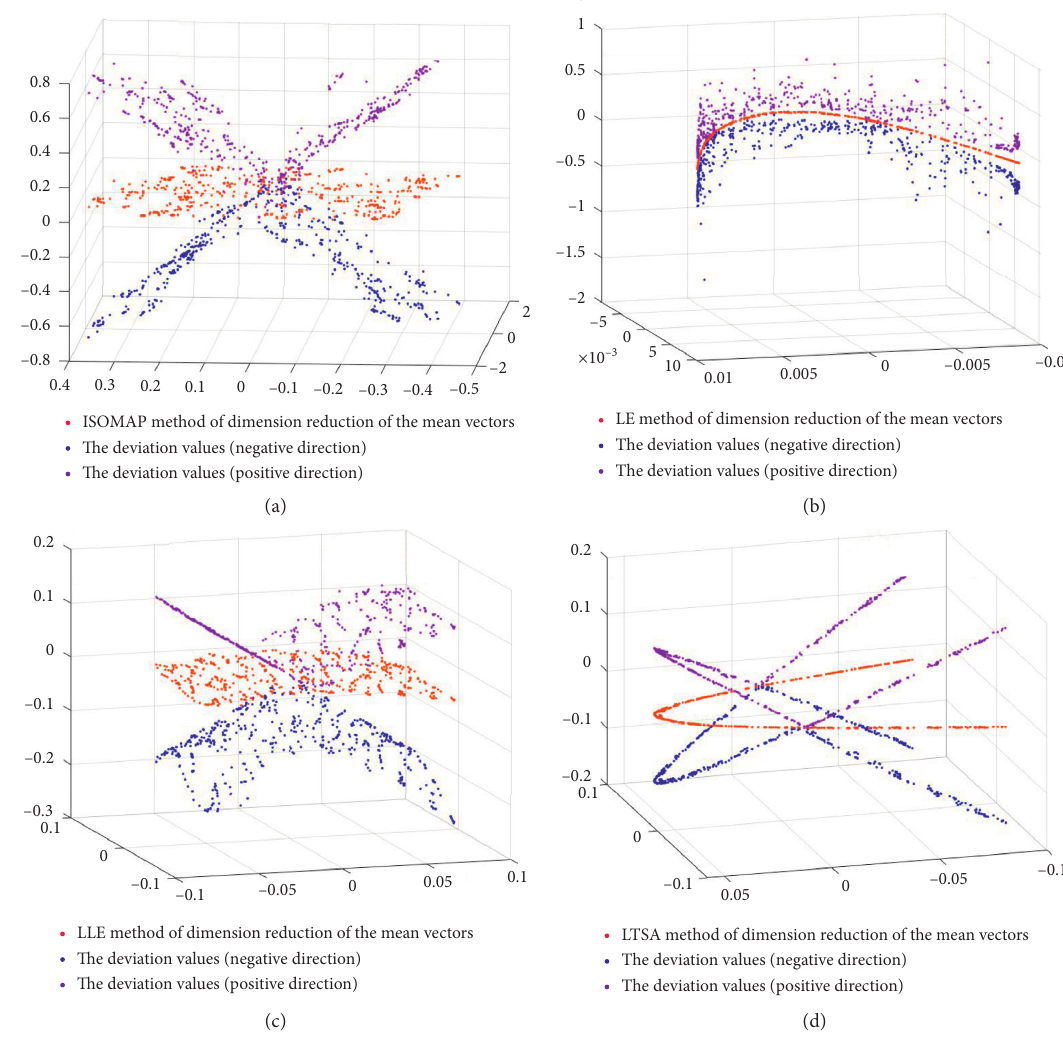
Figure 13: Dimension reduction of the mean vectors and deviation values in low-dimensional space of each anchor